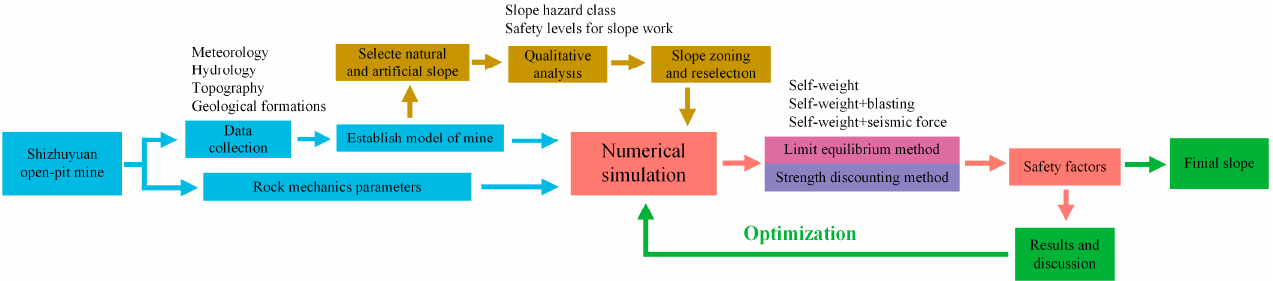
Figure 2. Flow diagram of stability analysis.